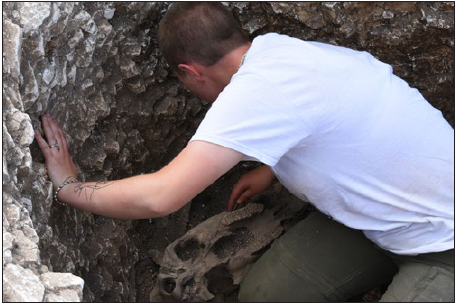
Figure 10: First year student Caragh Murphy- Collinson in one of the Iron Age pits with an inverted horse cranium. Photo: MBR.